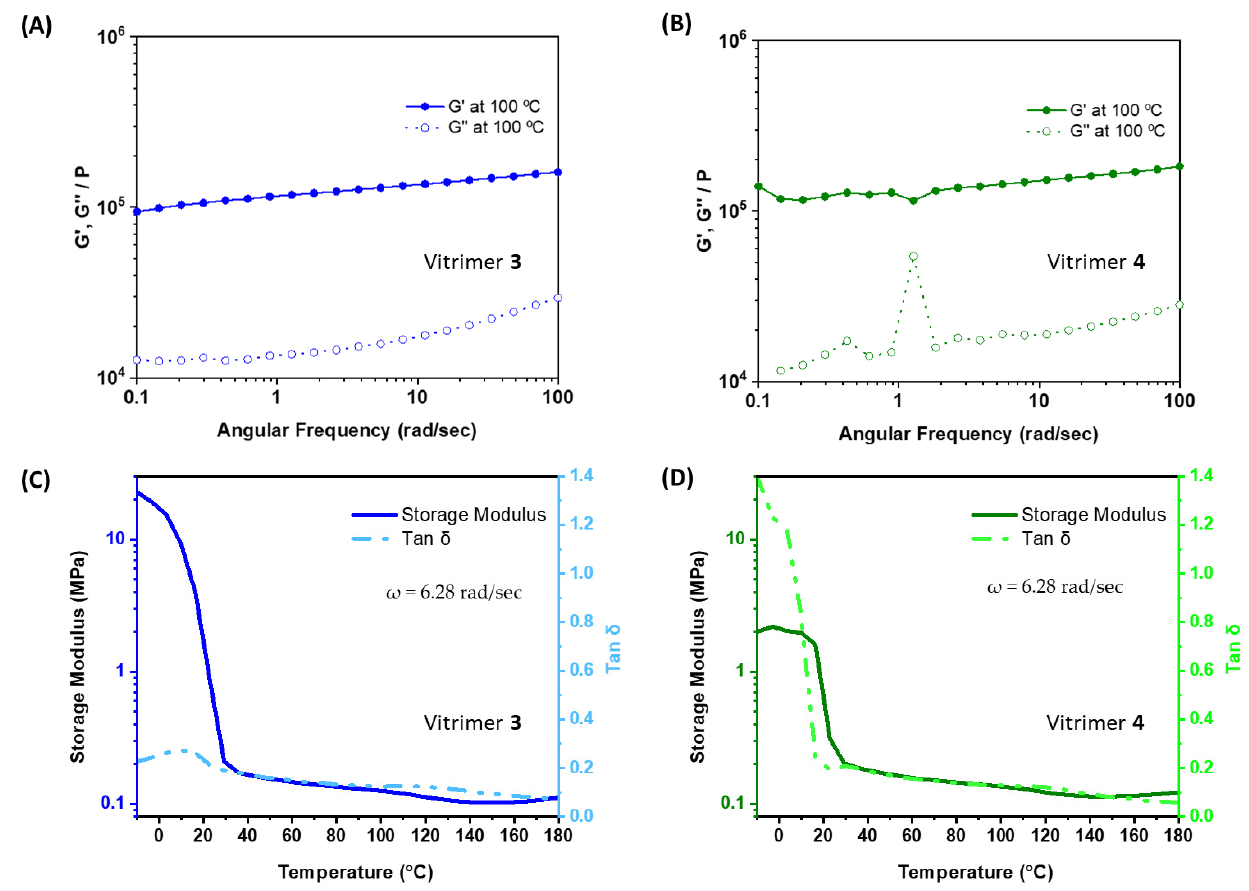
Figure 7. An investigation of storage and loss moduli upon frequency sweep on vitrimers 3 ( A ) and 4 ( B ), as well as G ′ and Tan δ vs. temperature of vitrimers 3 ( C ) and 4 ( D ). 4 ( B ), as well as G (cid:48) and Tan δ vs. temperature of vitrimers 3 ( C ) and 4 ( D